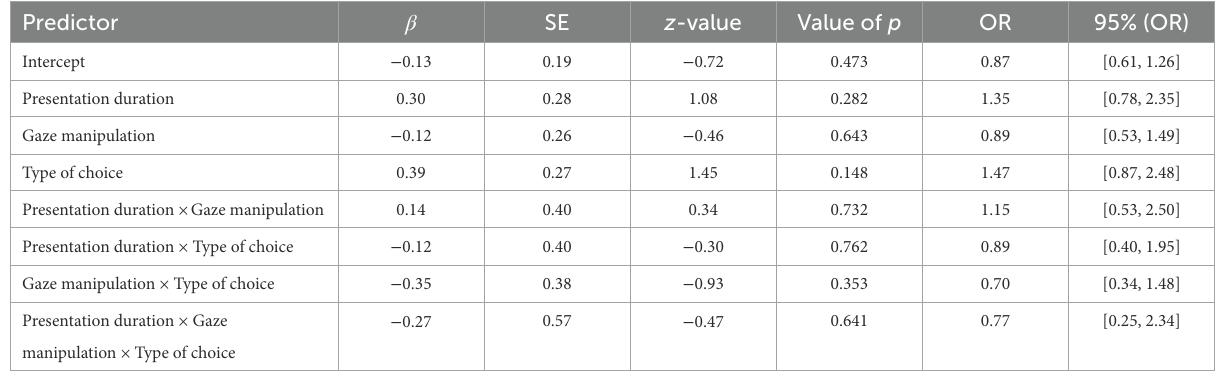
TABLE 2 Fixed effects from the registered analysis predicting the choice in Study